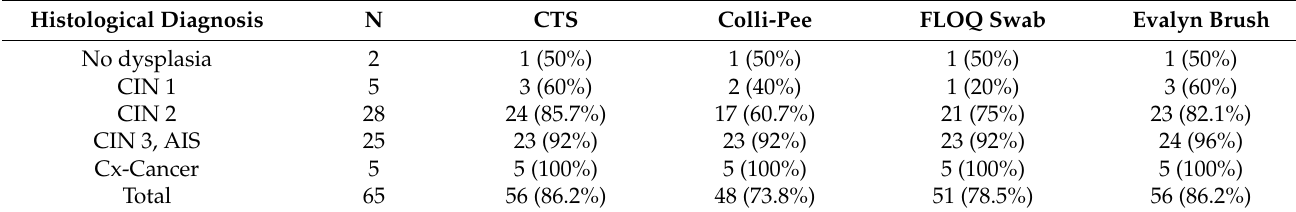
Table 1. HPV positivity according to histology in clinician-taken smears (CTS), self-collected urine samples (Colli-Pee), FLOQSwab and Evalyn Brush samples.